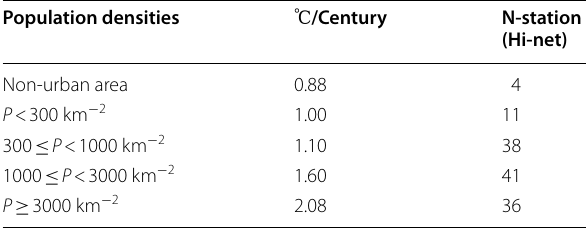
The number of Hi-net observation points applicable to each case is also shown